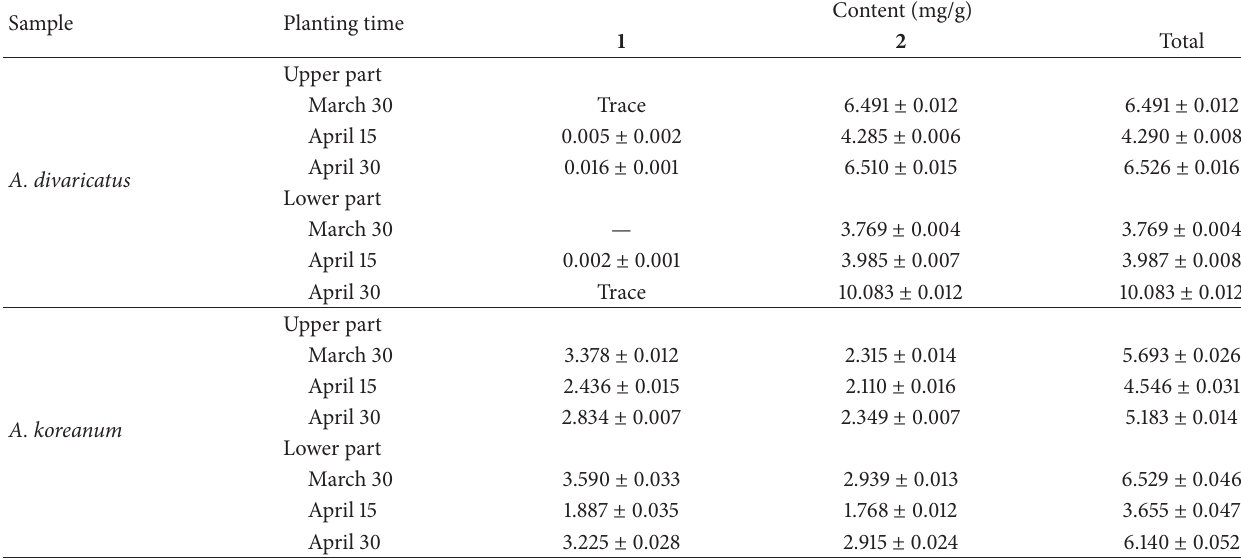
Table 3: The contents of eleutherosides B ( 1 ) and E ( 2 ) in A. divaricatus and A. koreanum planted at varying times. Sample